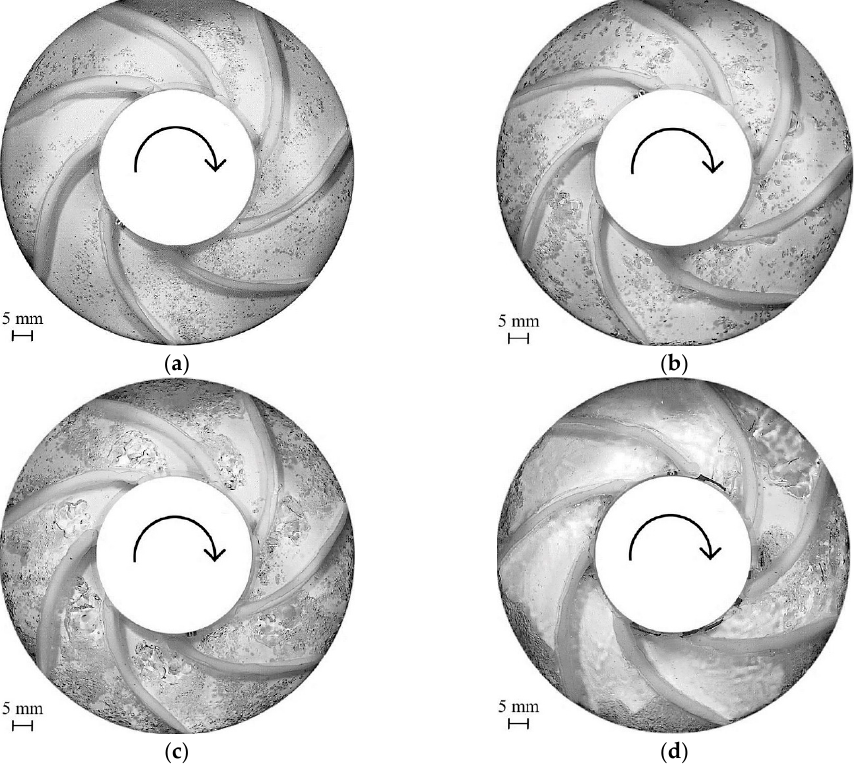
Figure 10. Visualized flow patterns in a rotating ESP impeller [68]. ( a ) Bubble flow pattern; ( b ) agglomerated bubble flow pattern; ( c ) gas-pocket flow pattern; ( d ) segregated flow pattern.